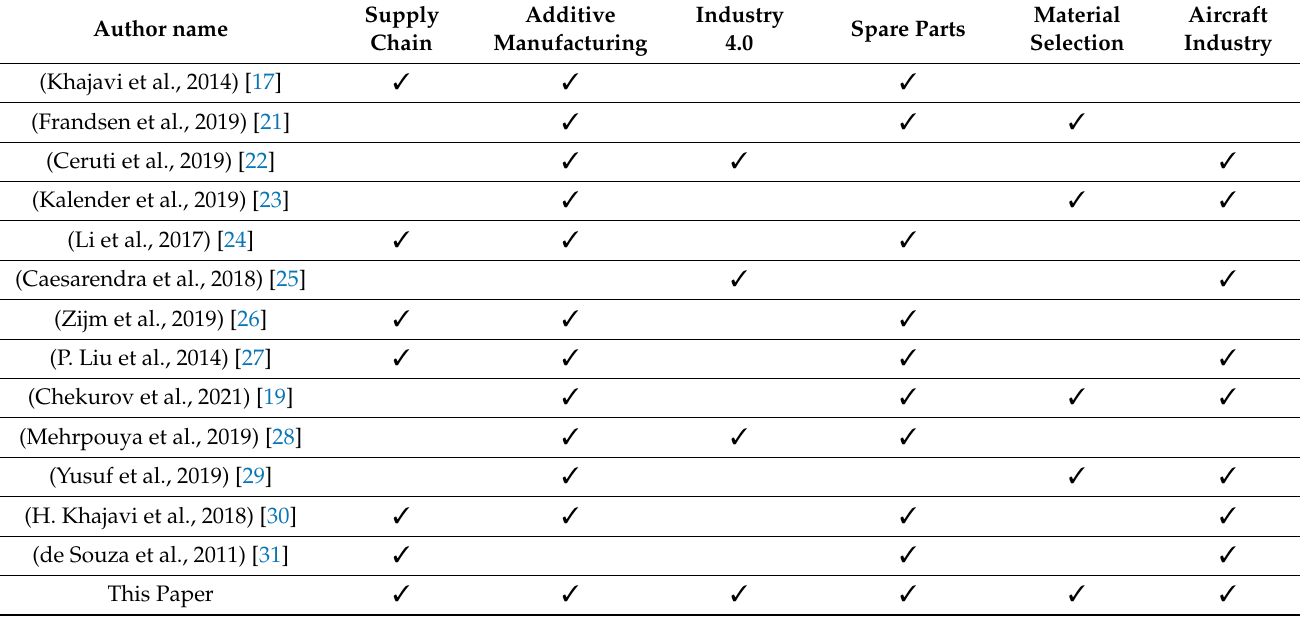
Table 1. Summary contribution of related